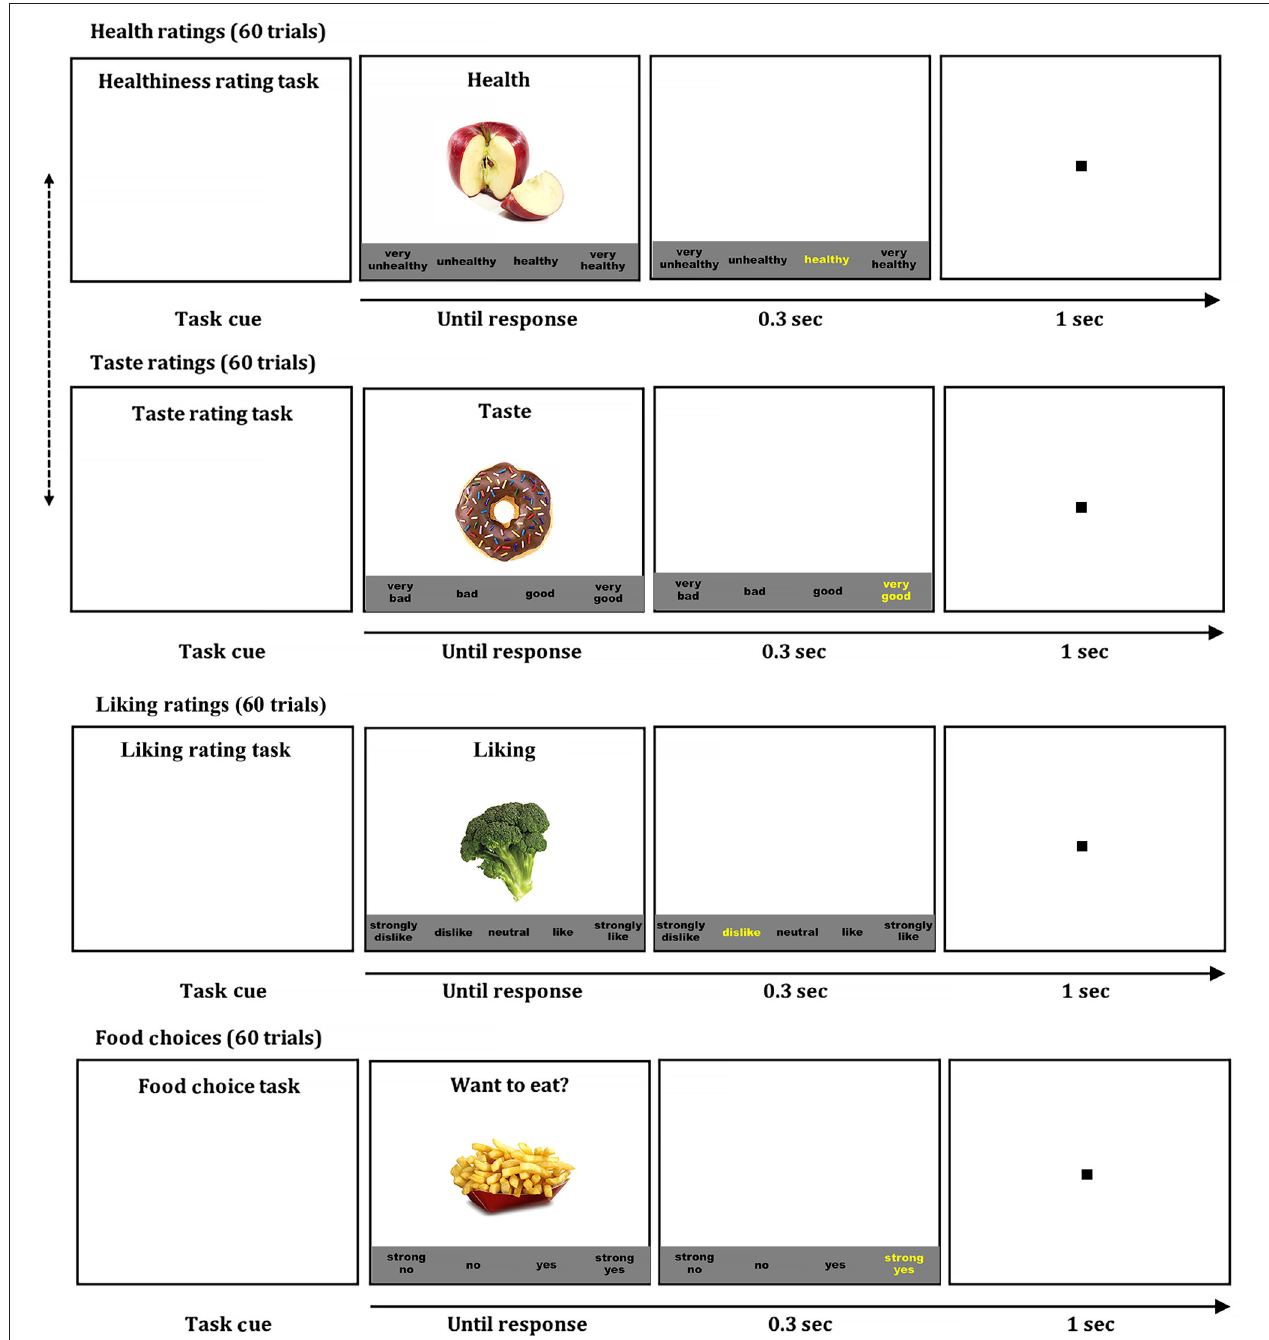
FIGURE 1 | Food ratings and choice tasks. Examples of food healthiness, taste, and liking ratings, and choice tasks. Pressing a space bar presented a colored food image on the screen, which was remained until a response. The order of food items was randomized in each tasks, and the order of health and taste ratings were counterbalanced across